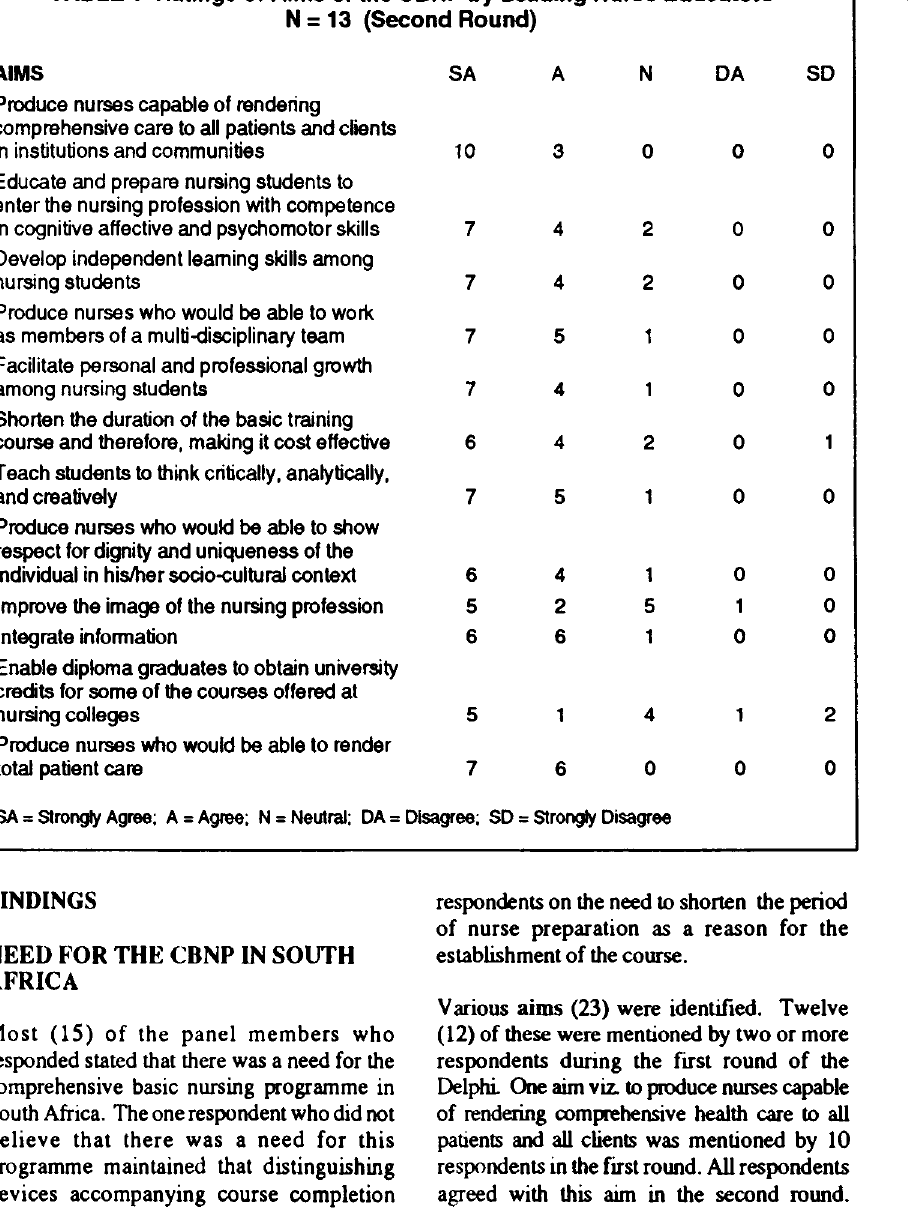
TABLE 1 Ratings of Aims of the CBNP by Leading Nurse